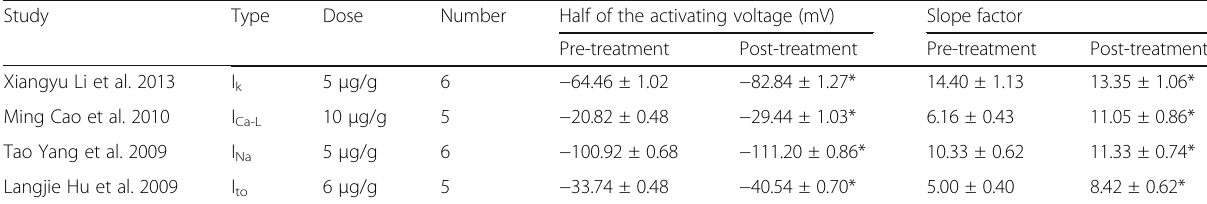
Table 5 The detailed information of the inactivation curve Study